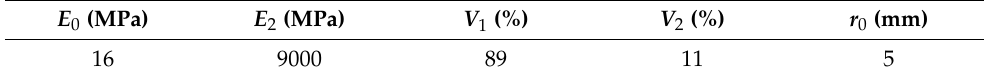
Table 4. Values of fitting